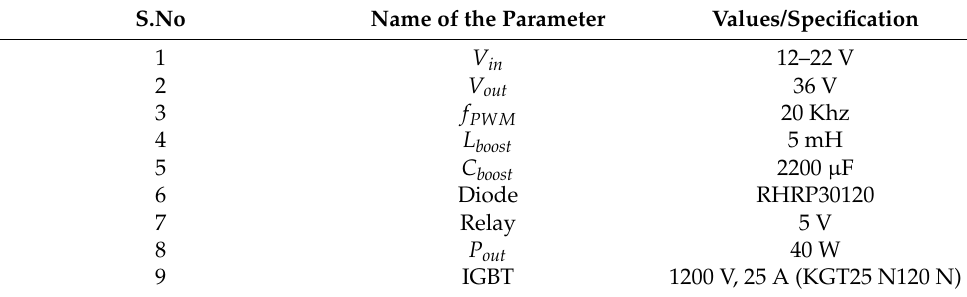
Table 2. Parameters of DC–DC boost converter.